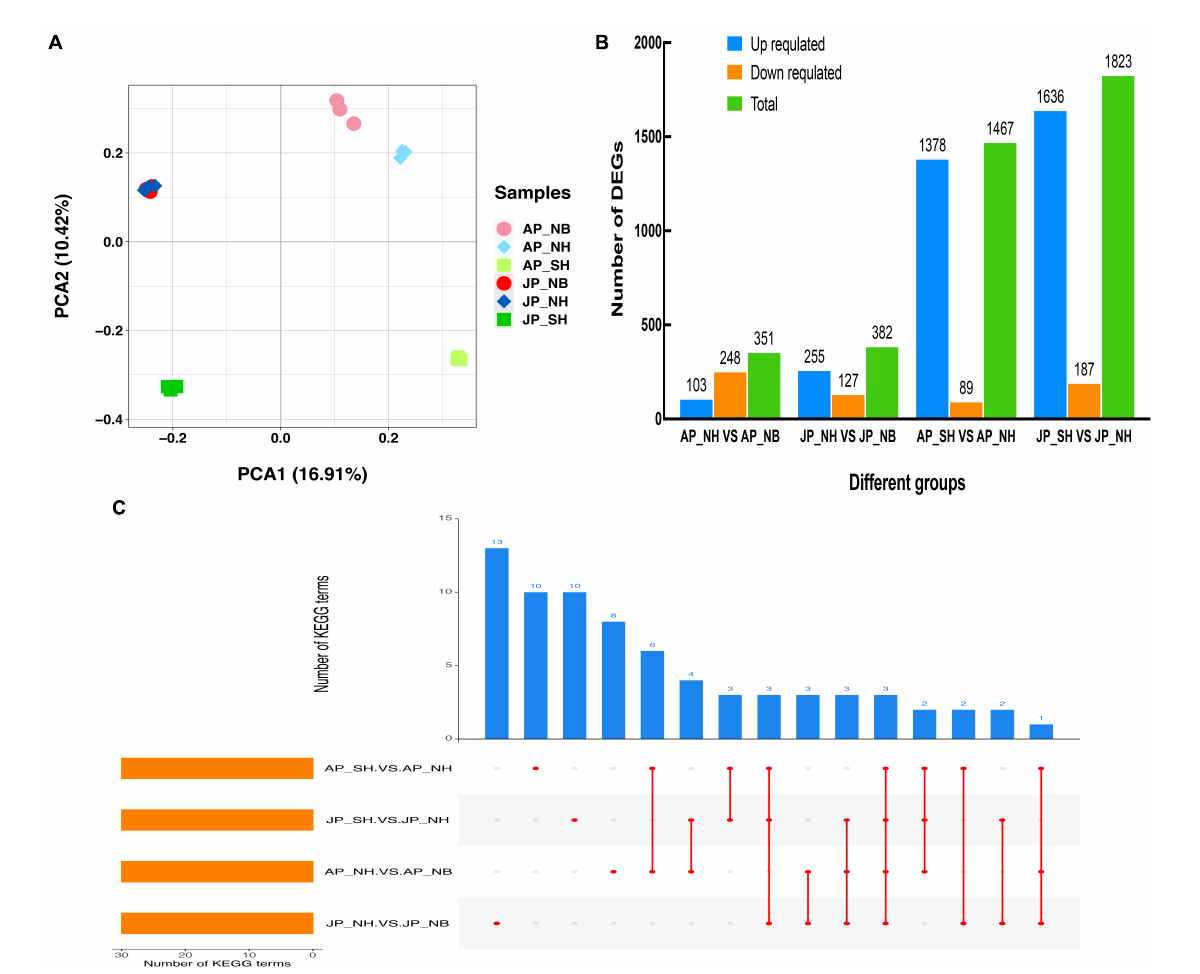
FIGURE4 (A) Principal component analysis (PCA) score plot genes profiles from different groups. (B) Number of differentially expressed genes (DEGs) in different comparison groups. (C) The number of KEGG pathways of DEGs in different comparison